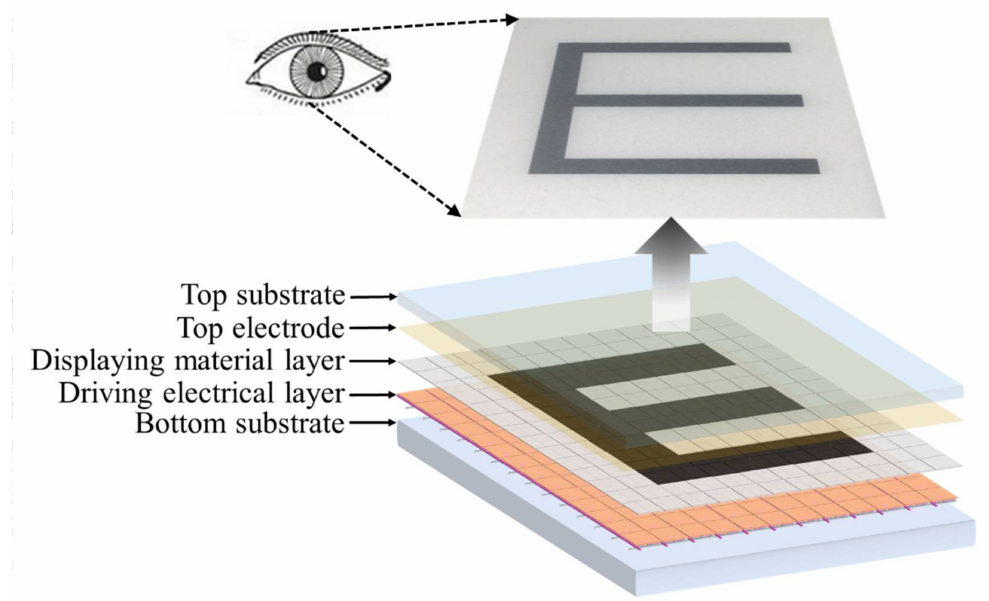
Figure 1. Schematic of a reflective display